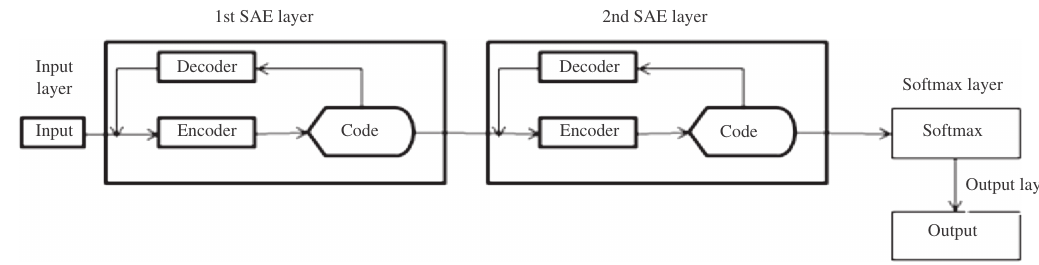
Figure 4: Structure of Deep Neural